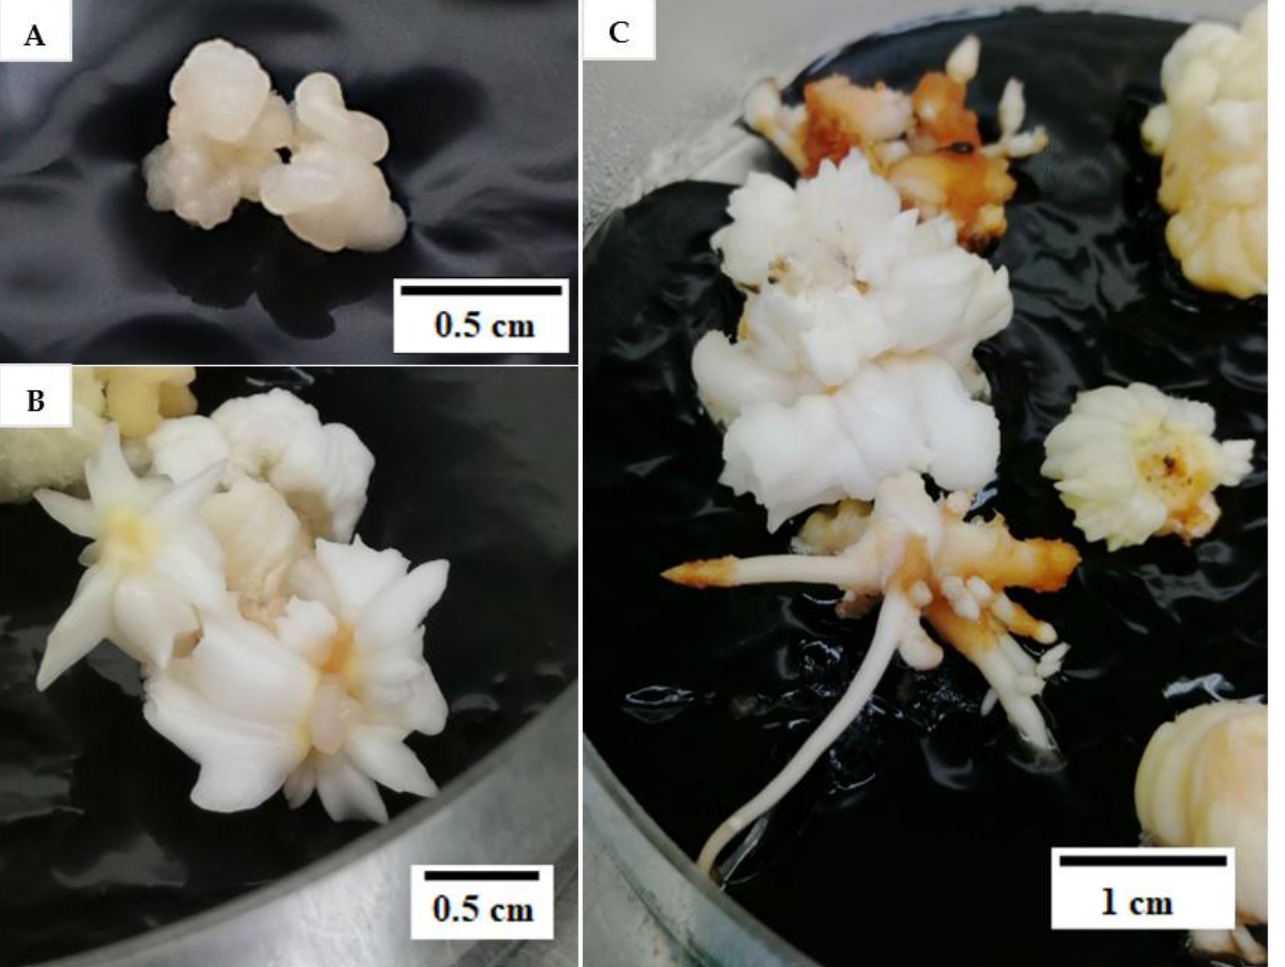
Figure 3. ( A ) Compact embryogenic callus (EC) used in the study to form friable EC. ( B ) Mature somatic embryos and ( C ) roots forming on compact EC after two subculture cycles.